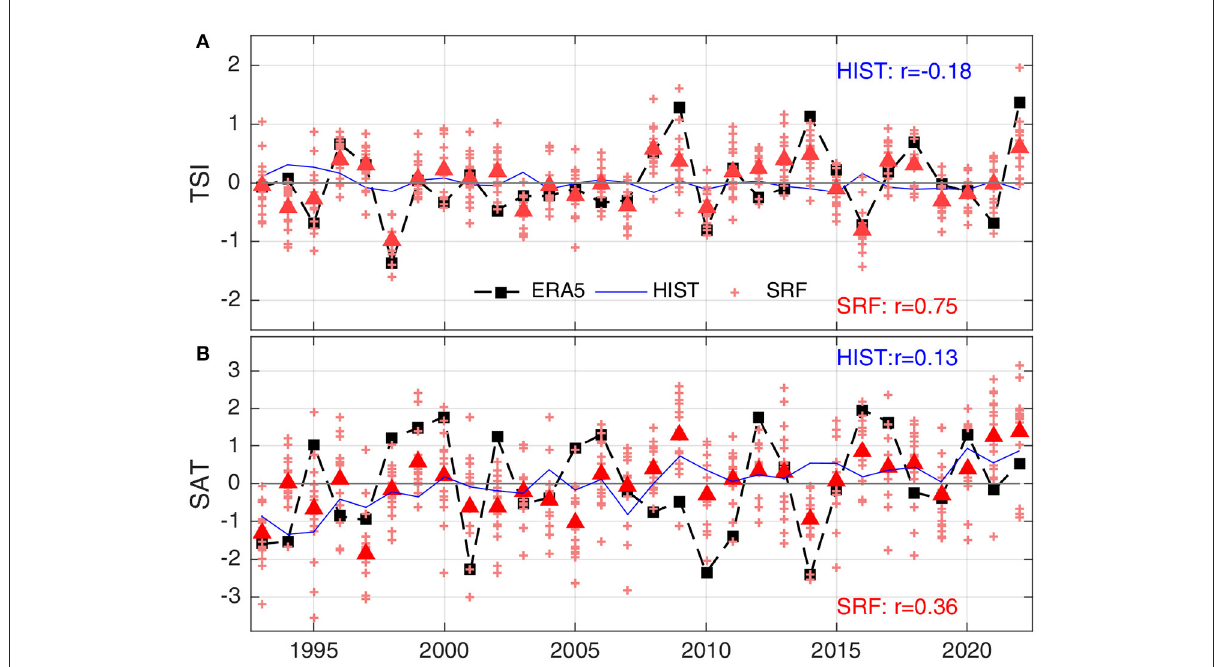
FIGURE10 Time series of observations (black squares), ensemble mean estimates from SPEAR’s historical simulations (HIST, blue) and SRF (red triangles) averaged over the central United States (marked as a black box in Figure 4) for December–February during 1992–2022 for (A) the Temperature Swing Index (TSI, units in K) and (B) mean surface air temperature (SAT, units in